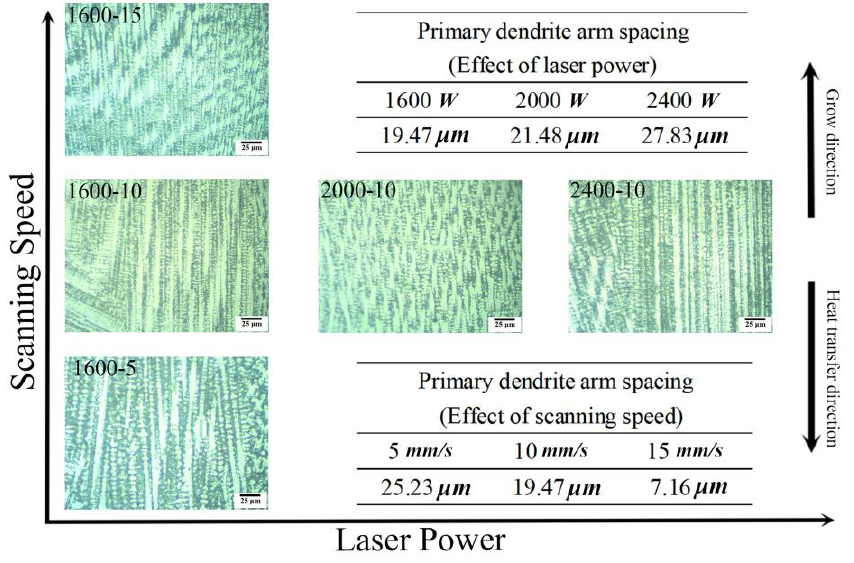
Figure 4. Effects of laser power and scanning speed on sample PDAS.